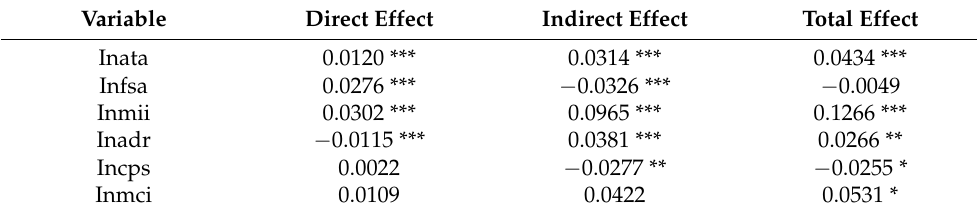
Table 13. Decomposition results of the spatial effect of agricultural technology application on agricultural green development under the economic